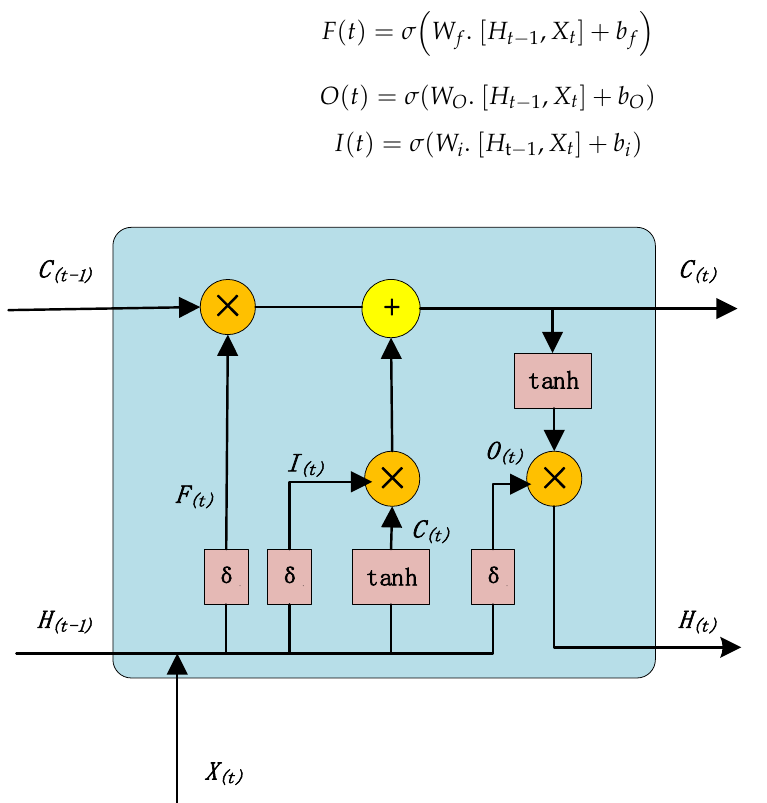
Figure 4. LSTM unit architecture.